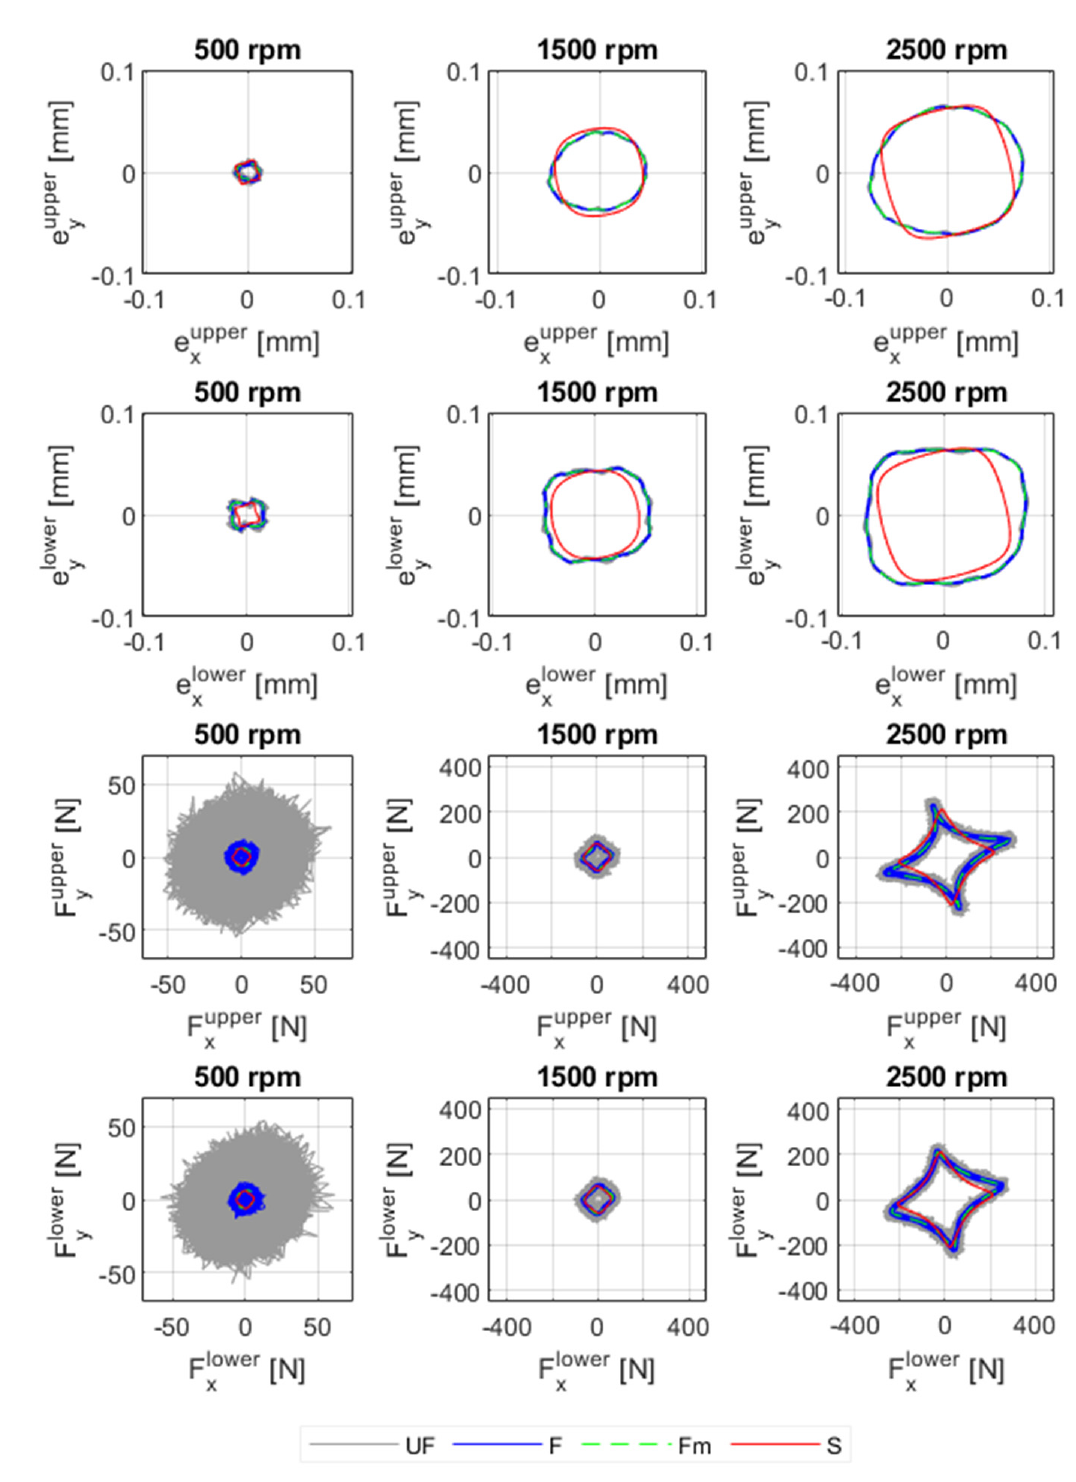
Figure A2. Orbits and bearing forces of the upper and lower bearings with 3.8 × 10 − 3 kg · m unbalance magnitude and at 500 rpm, 1500 rpm, and 2500 rpm. UF: unfiltered measurement signal; F: filtered measurement signal by a band pass filter; S: simulation.